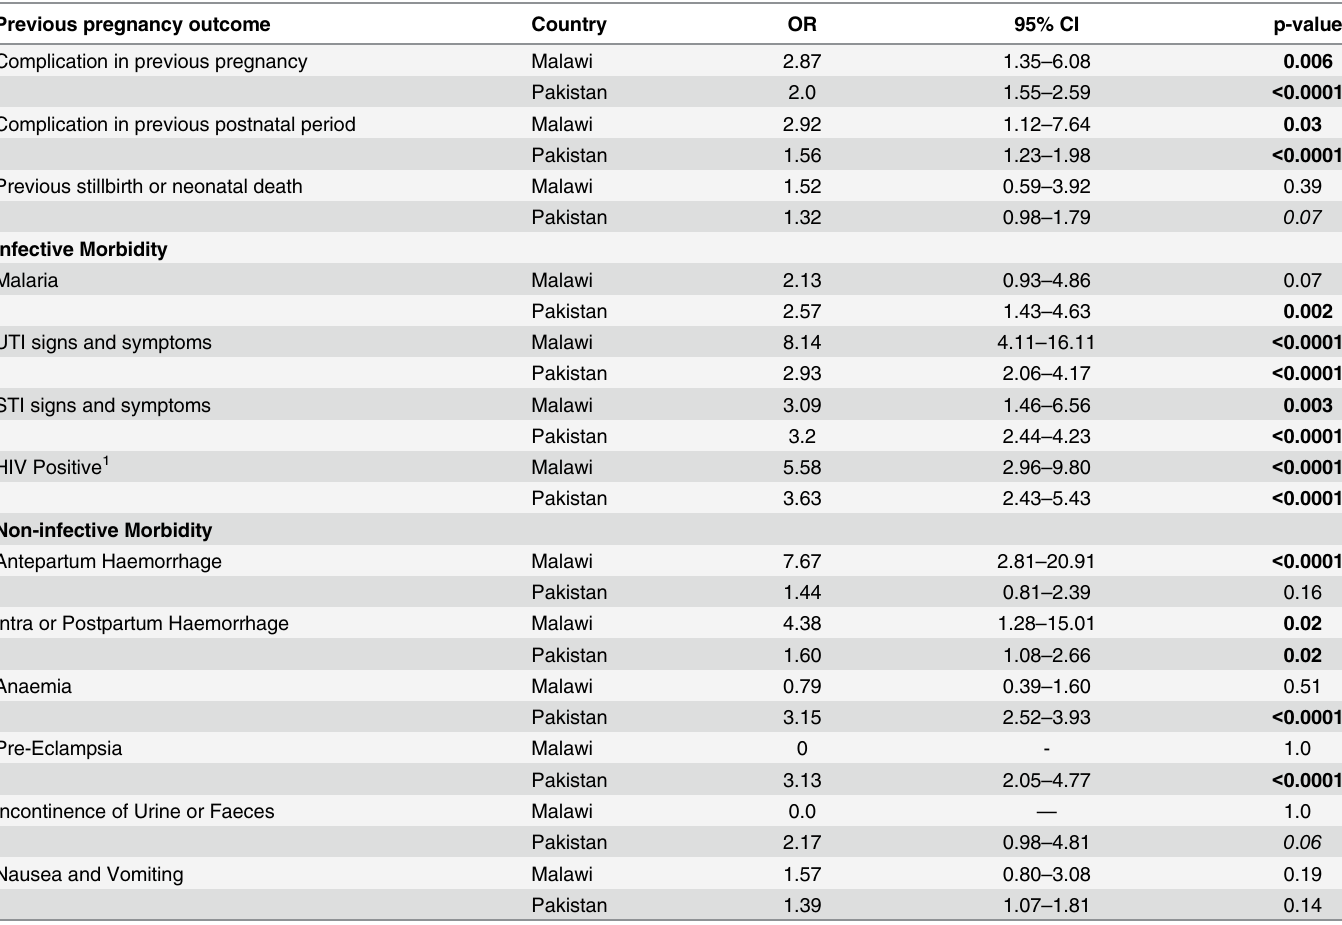
Table 7. Association between psychological morbidity, infective morbidity, non-infective morbidity and previous pregnancy